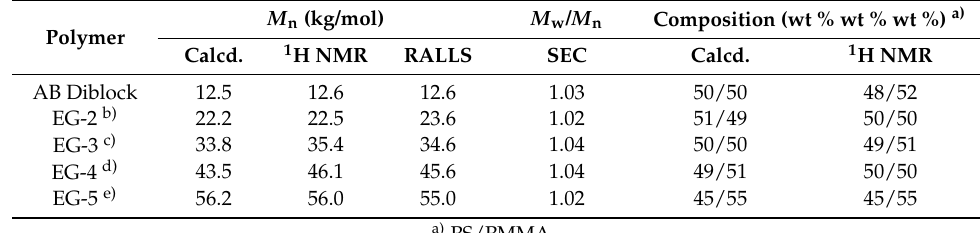
Table 6. Characterization results of exactly defined (PMMA– graft –PSt)s synthesized by the iterative methodology.